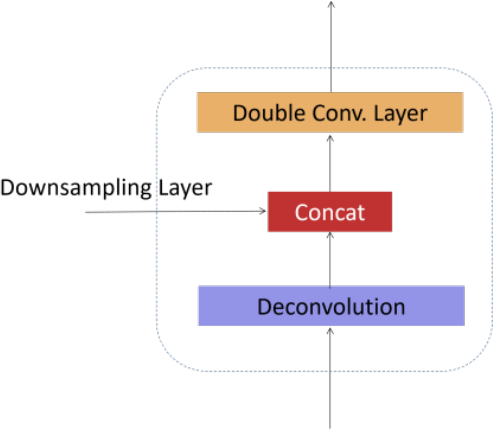
Figure 5. The architecture of the upsampling